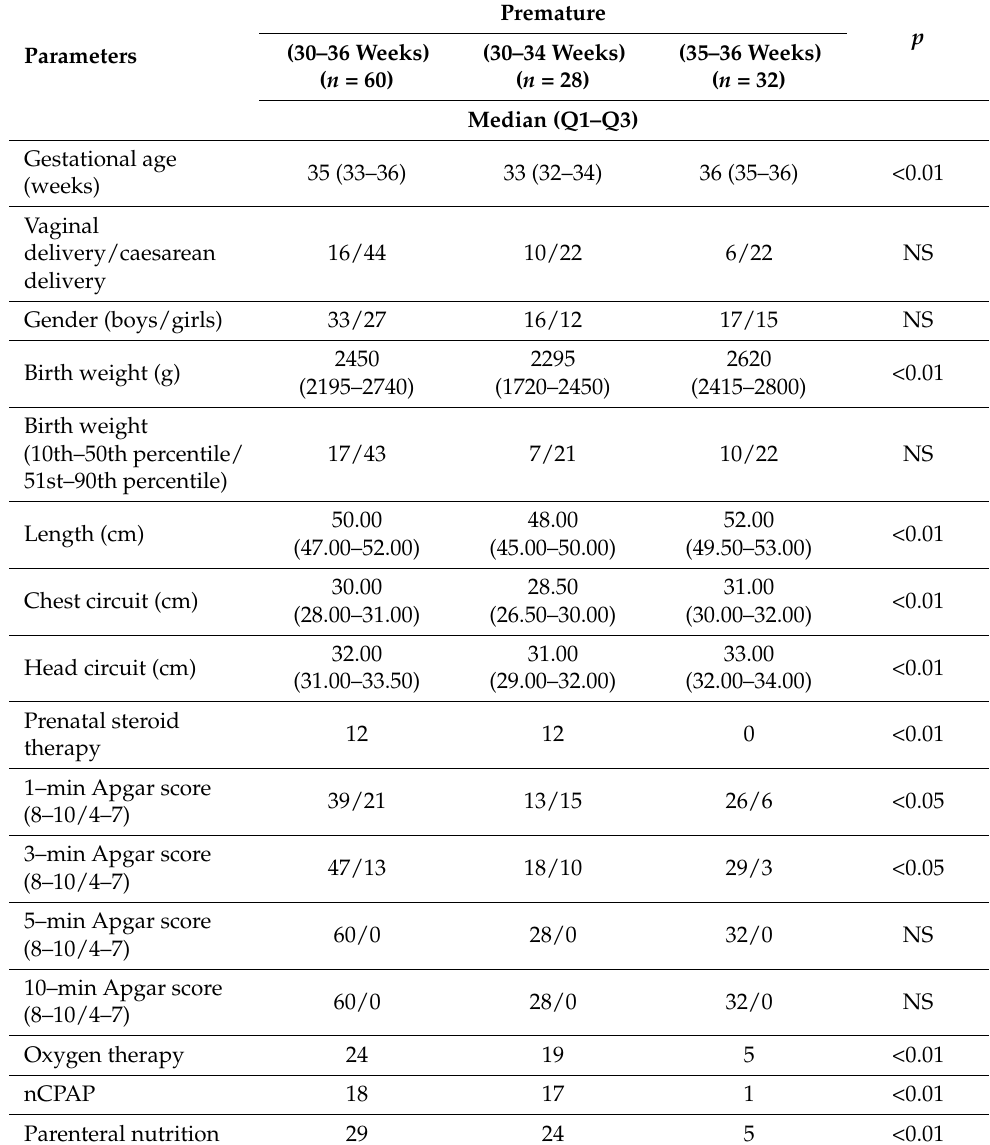
Table 1. Characteristics of premature